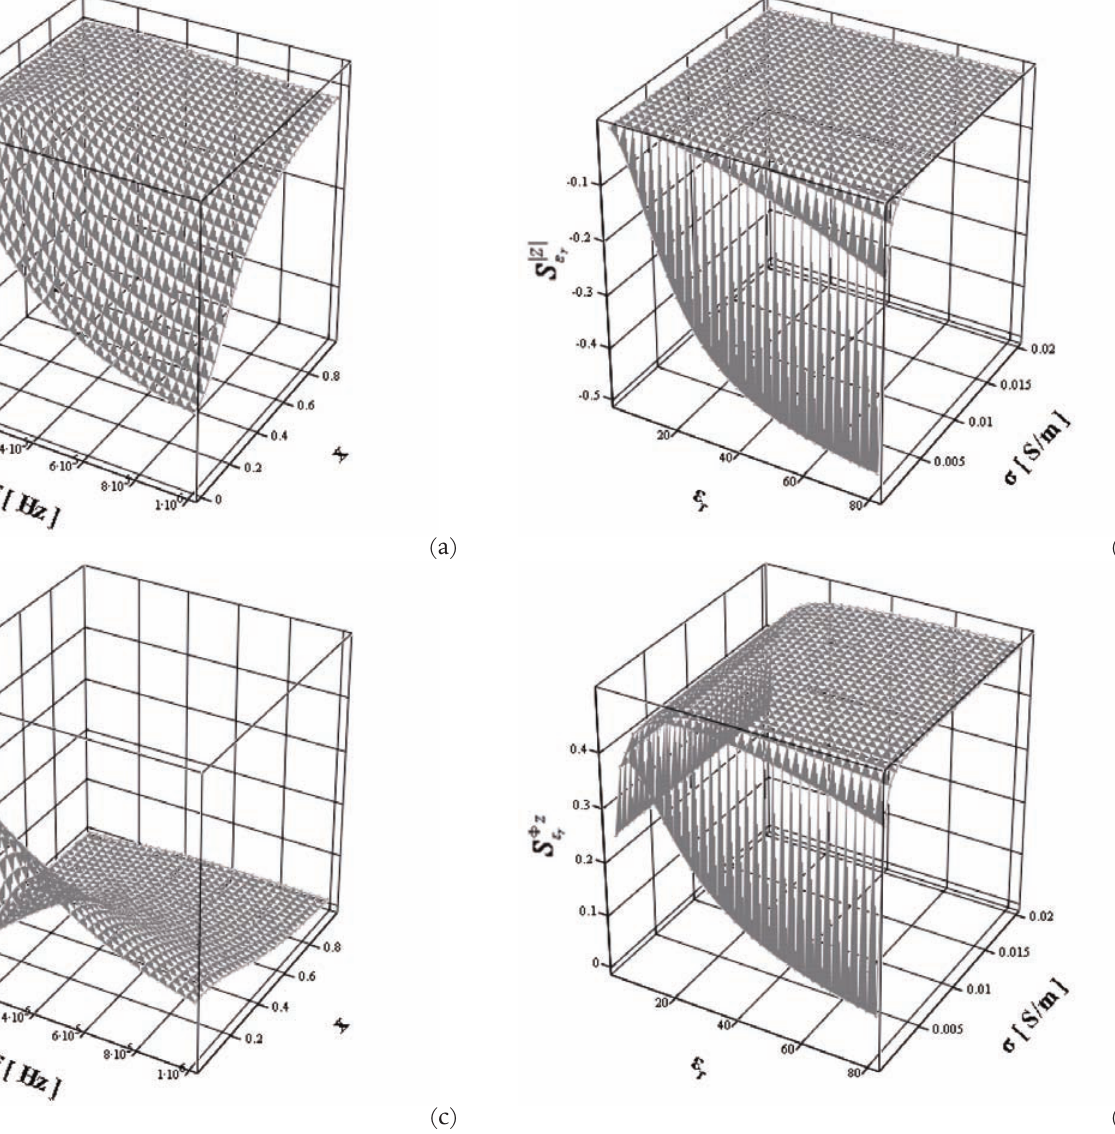
Figure 4. Sensitivity functions and for the transfer impedance both in modulus | Z | and in phase U (a, c) as functions (a) and (c) of both the working frequency f and the height/dimension ratio x = h / L under the same operative conditions as Figure 3a; (b, d) as functions (b) and (d) of both the conductivity v and the permittivity f conditions as Figure